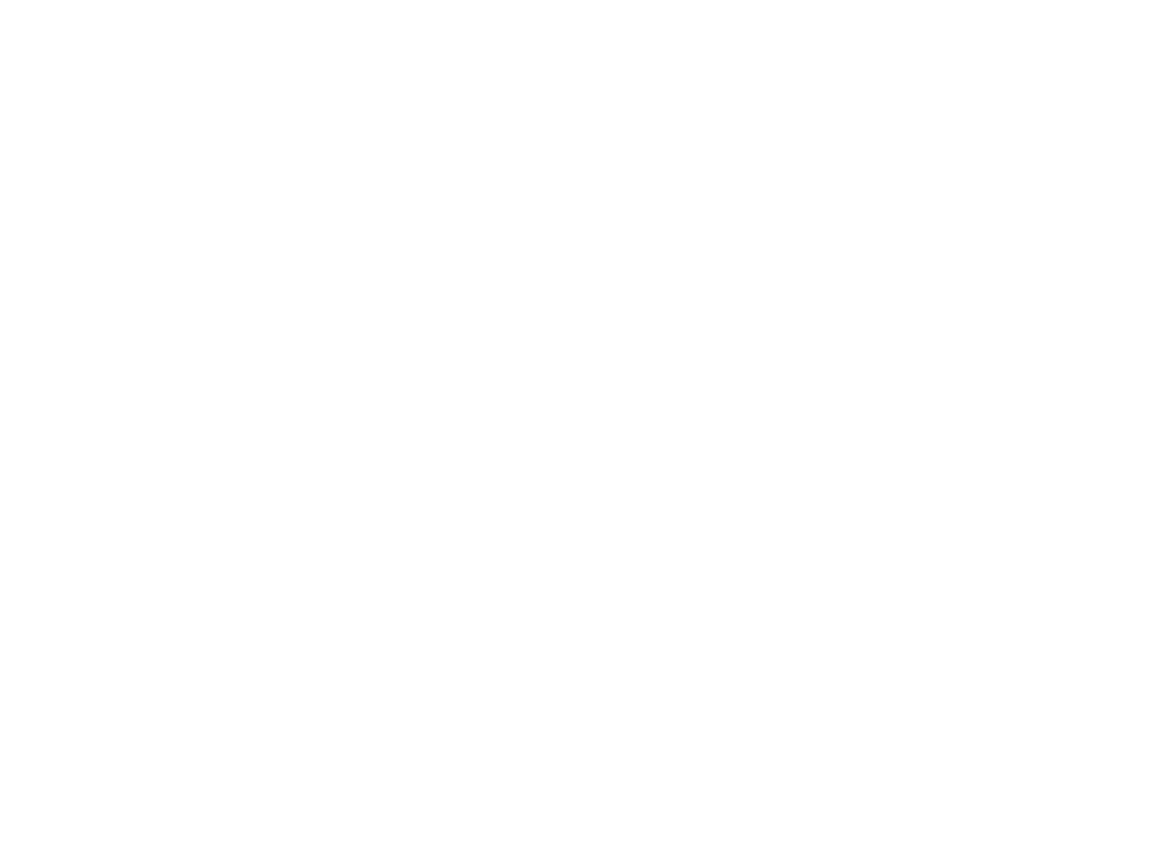
Frontiers in Molecular Biosciences |